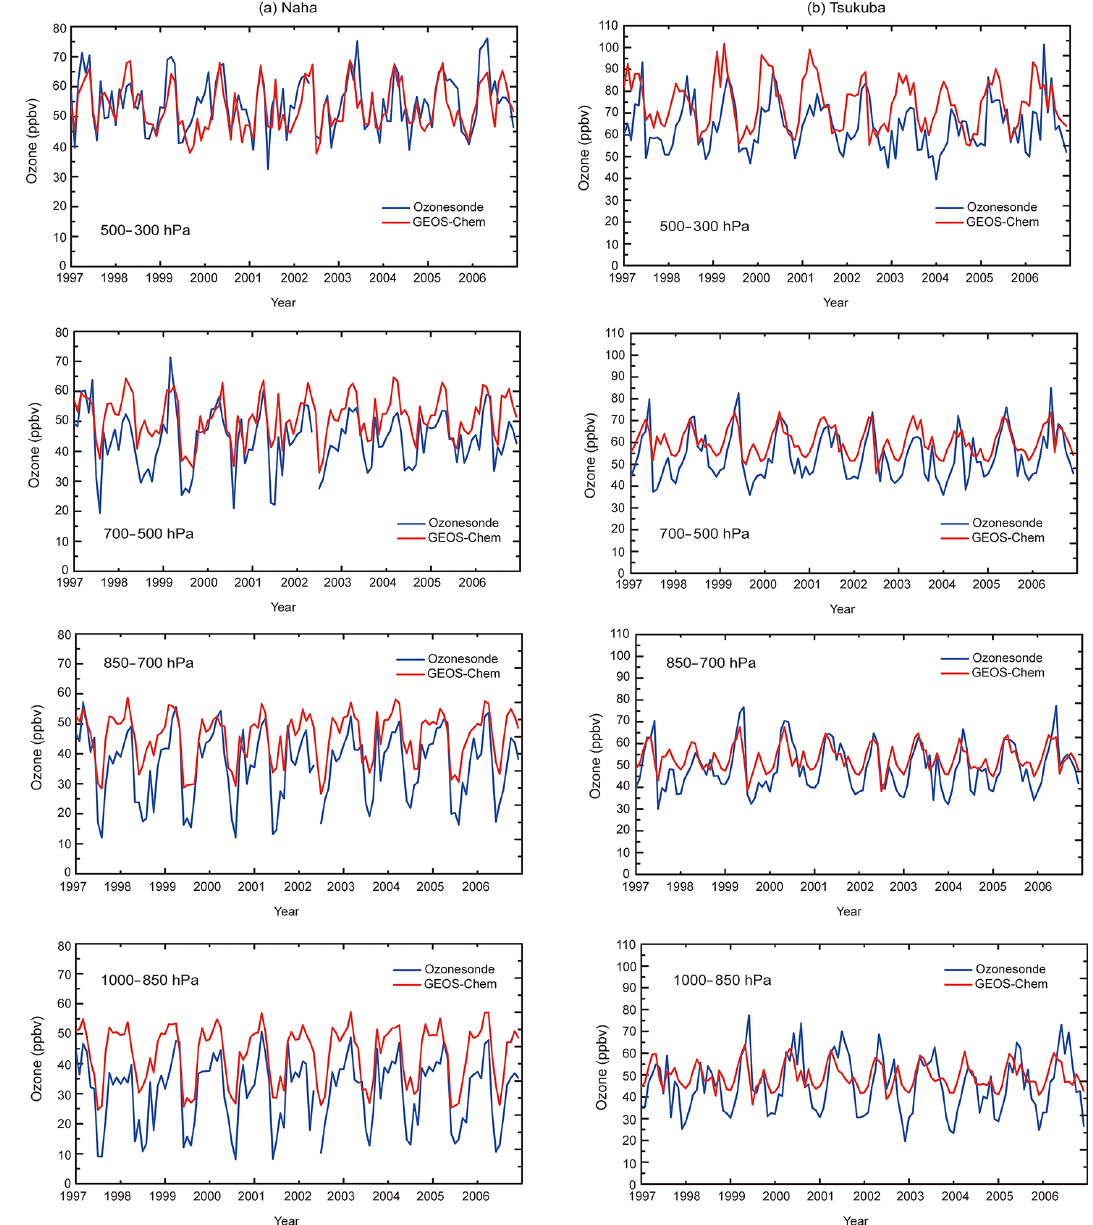
Figure 4. The time series of monthly O 3 mixing ratios measured by ozonesonde (the blue line) and simulated by MetEmisB (the red line). (a) Naha and (b) Tsukuba are ozonesonde sites from the WOUDC. The comparisons are shown for four altitude levels in the